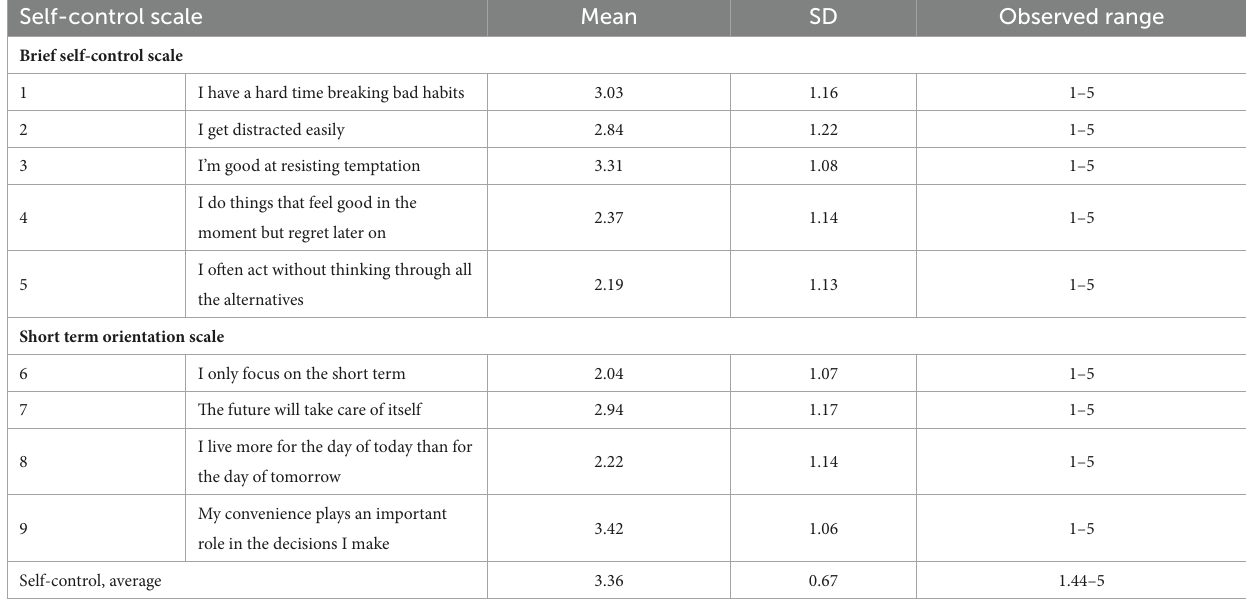
TABLE 4 Summary statistics of the self-control scale.